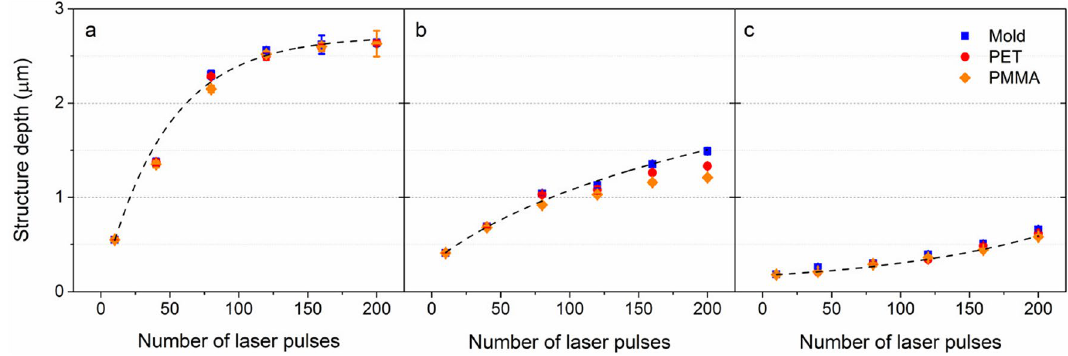
Figure 2. Evolution of structure height as a function of laser pulses for the spatial period of ( a ) Λ = 4.6 µm, ( b ) Λ = 2.7 µm and ( c ) Λ = 1.6 µm. The black dashed lines are guides to the